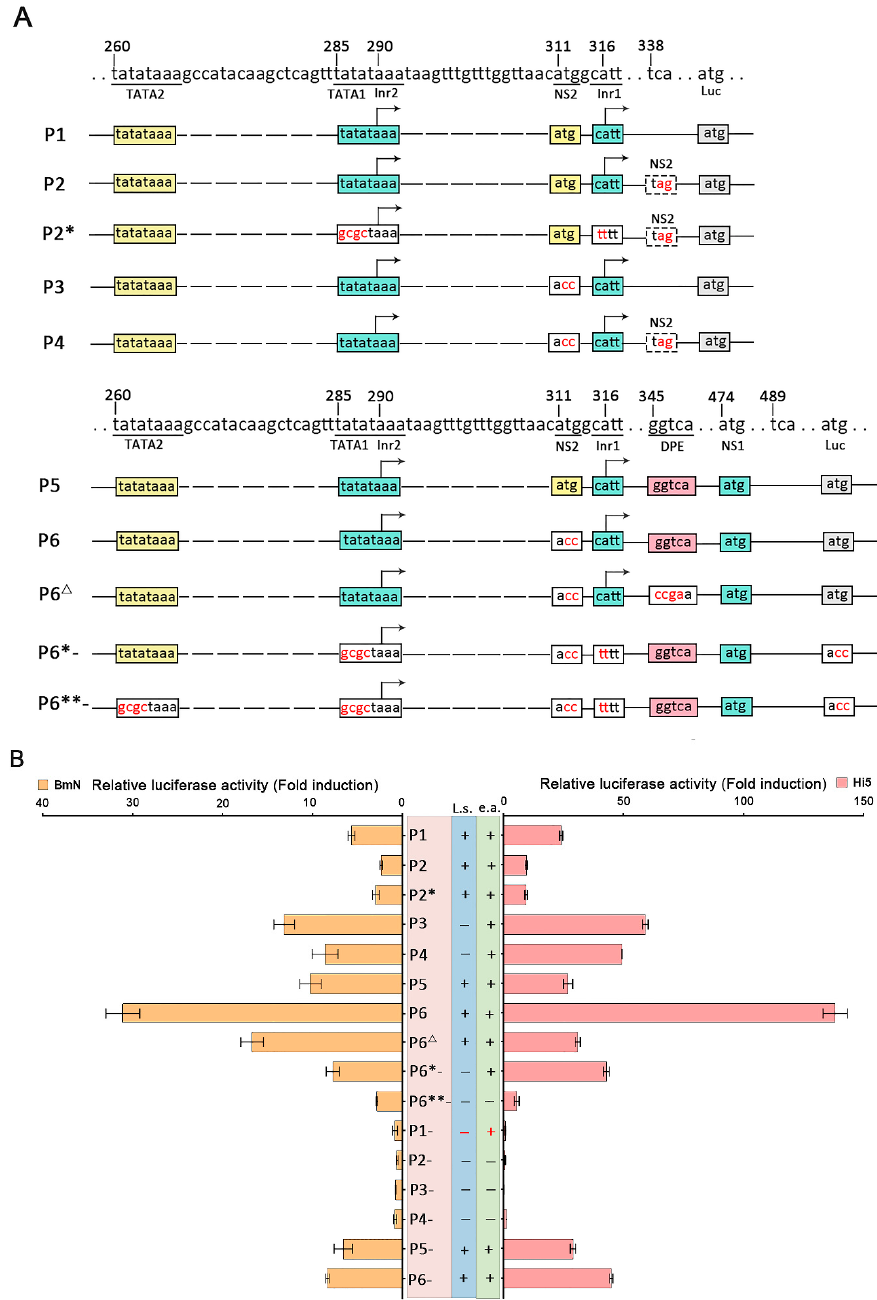
Figure 4. Analysis of P5/5.5 promoter elements using the luciferase reporter system. ( A ) The luciferase reporter plasmids contain NS1 and NS2 transcription initiation sites (Inr1 and Inr2), an NS1 or NS2 initiation codon (ATG), and its intact upstream promoter elements. In the constructs, the boxes represent elements, and the gray boxes represent replaced sequences. In addition, mutants were made for all constructs in which the initiation codon of luciferase was mutated (P1- to P6-), and two constructs, TATA1 and Inr1 (for NS1 transcripts), were mutated (indicated by * ). ** represents Inr1. TATA1 and TATA2 all were mutated, and then DPEs were mutated (indicated by ∆ ). ( B ) The observed luciferase activity. The tendency of activity levels to change in different insect cells (Hi5, BmN) was consistent (“l.s.” represents luciferase activity if leaky scanning occurs and “e.p.” represents overall expected activities). (n = 3), Error bars denote standard